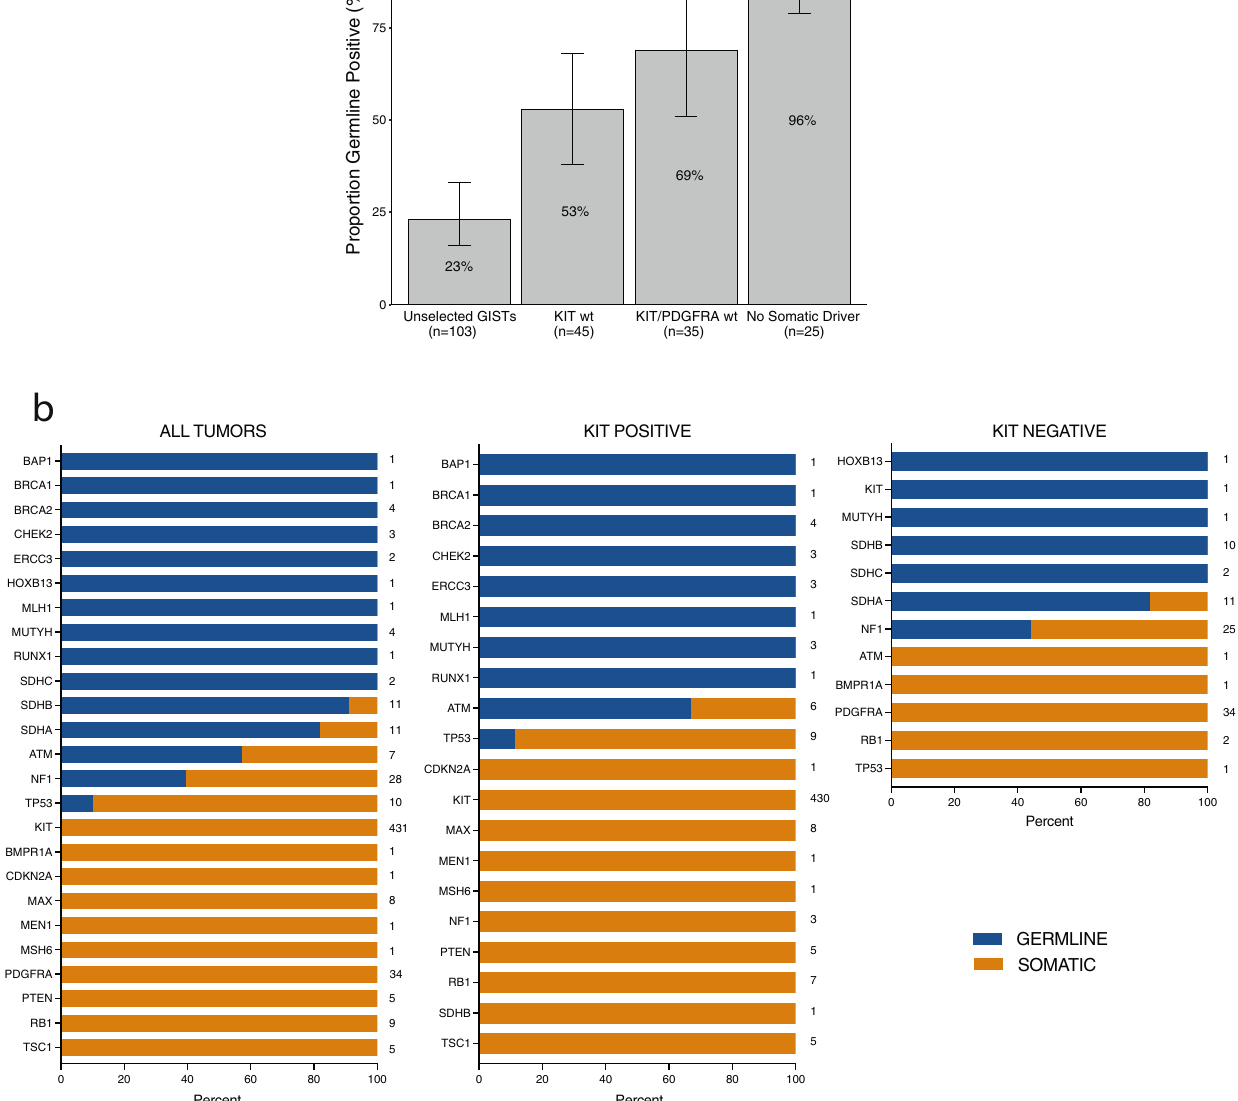
Fig. 2 Detection of germline P/LP variants in GIST patients based on somatic pro fi les. a Proportion of patients with P/LP variants in GIST- associated genes in the cohort of 103 patients who received germline genetic testing. Percentages are plotted and displayed on the bar graphs. Error bars represent con fi dence intervals calculated by the Clopper-Pearson method. b Distribution of germline (blue) and somatic (orange) P/LP variants detected in tumor-only sequencing analysis of de-identi fi ed GISTs from 499 patients. Data from all tumors (left), KIT - mutant tumors (middle), and KIT -wildtype tumors (right) are presented. Numbers displayed on the right of each gene data on each plot represent the number of tumor samples with variants identi fi ed in each gene in that group of